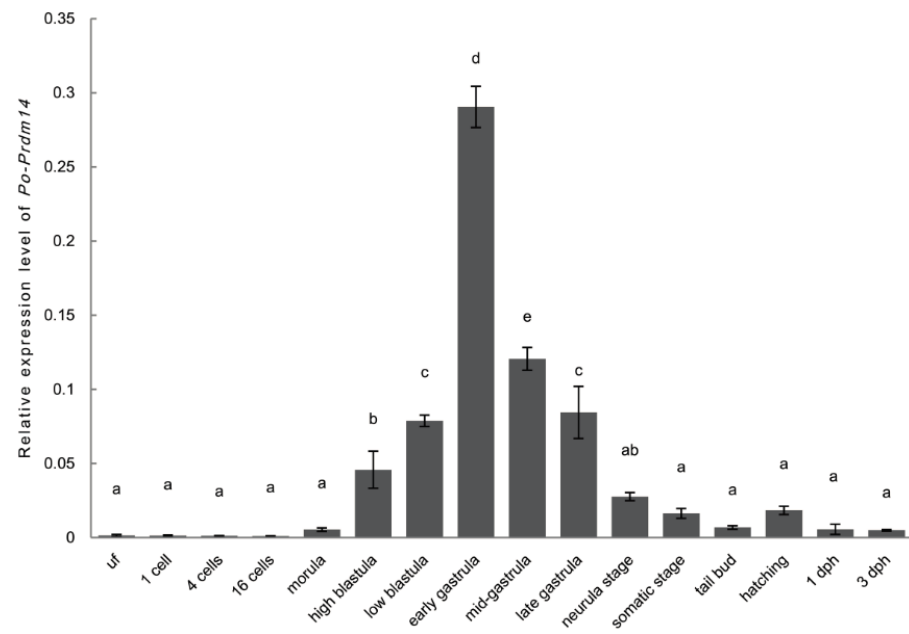
Figure 7. Relative expression of Po-prdm14 during embryo development from the unfertilized egg to the hatching stage in P. olivaceus . The relative expression variance is presented as a ratio (the amounts of Po-prdm14 mRNA normalized to the values of the corresponding reference genes). Data are shown as the mean ± SEM ( n = 3; p < 0.05). Groups marked with the same letters are not statistically different.